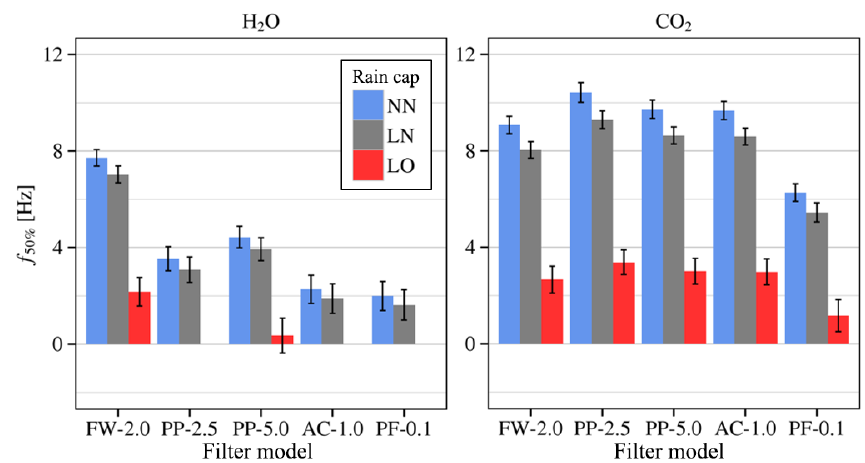
Figure 5. Half-power frequencies of filter and rain cap combinations without tube for H 2 O (left panel) and CO 2 (right panel) as determined by laboratory tests. Rain caps are NEON new (NN), LI-COR new (LN) and LI-COR old (LO). Filters are Swagelok FW-2.0, 3M/CUNO PP-2.5, 3M/CUNO PP-5.0, Pall AC-1.0 and ZenPure PF-0.1 (Table 2 provides detailed filter specifications). Values are determined by propagating combinations of individual filter and rain cap half-power frequencies (Table 5) through Eqs. (7)–(10). For H 2 O, the combinations of PP-2.5, AC-1.0 and PF-0.1 filters with the LO rain cap fall below the physically valid range of regression Eq. (7). Error bars represent the standard error resulting from Eq.